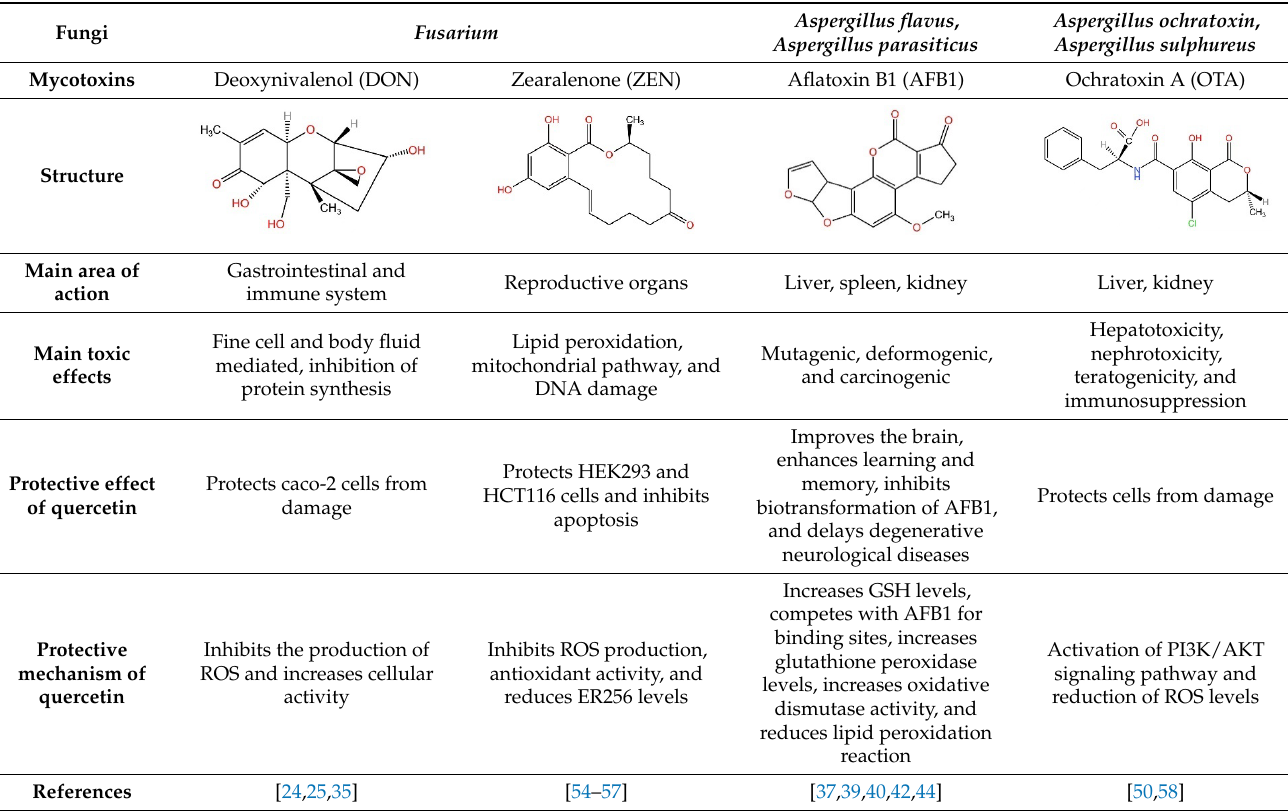
Table 1. Toxic effects of different fungal toxins and protective effects and mechanisms of quercetin.